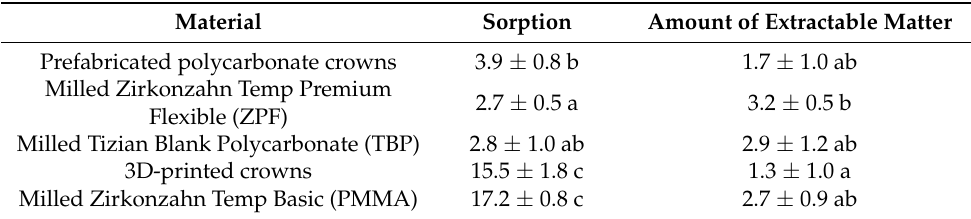
Table 2. Sorption and amount of extractable matter in the artificial saliva in µ g/mm 3 (Mean ± SD).